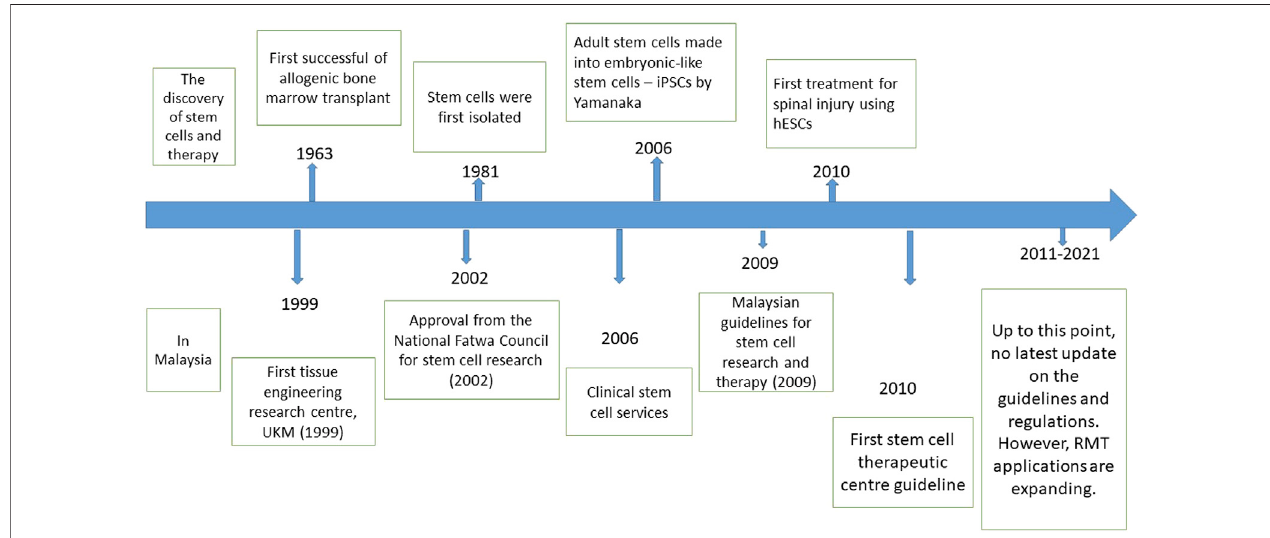
FIGURE 2 | (Top) The timeline of the most signi fi cant discovery of stem cells and therapy worldwide. (Bottom) The timeline of RMT development, including the regulations and fatwa involving stem cell research in Malaysia.